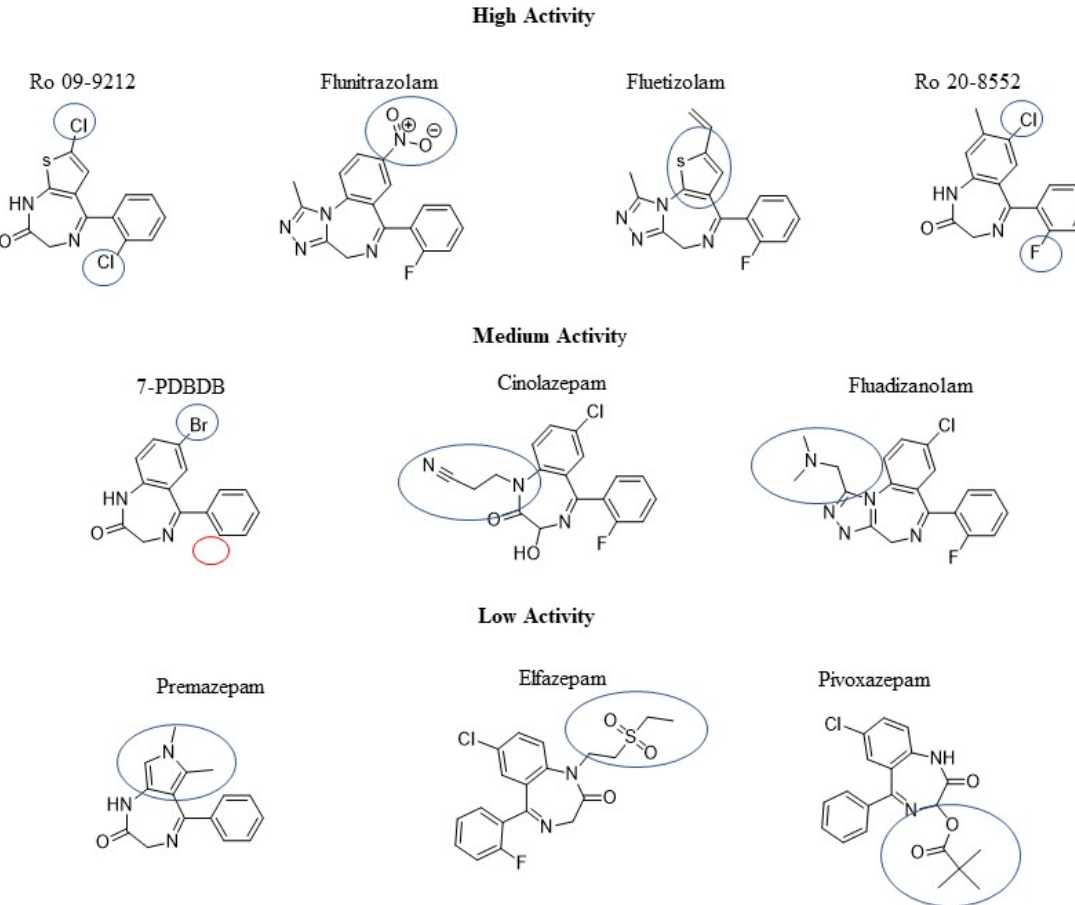
Figure 2. Example of 2D molecules belonging to the high, medium and low activity groups. Notes: In the figure, common chemical features across each activity bin are highlighted with a blue circle. The red circle instead indicates the lack of a substituent.